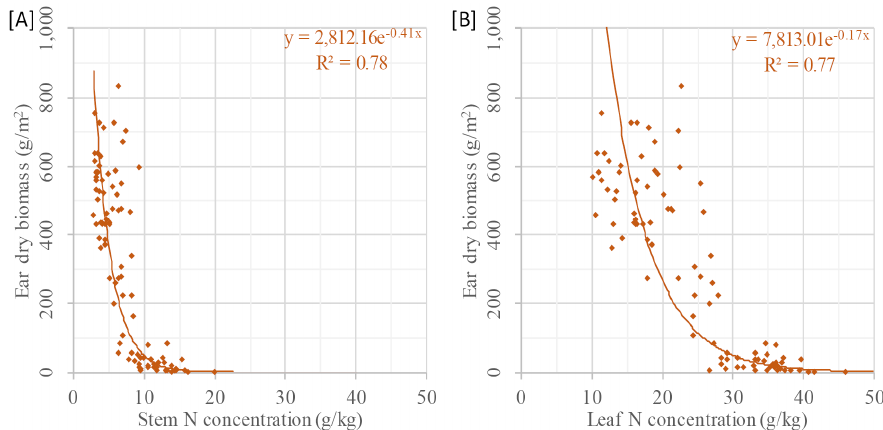
Figure 6. Scatterplots of the ear dry biomass vs. N concentration of stem and leaf [ B ] with best- fitting regression lines.